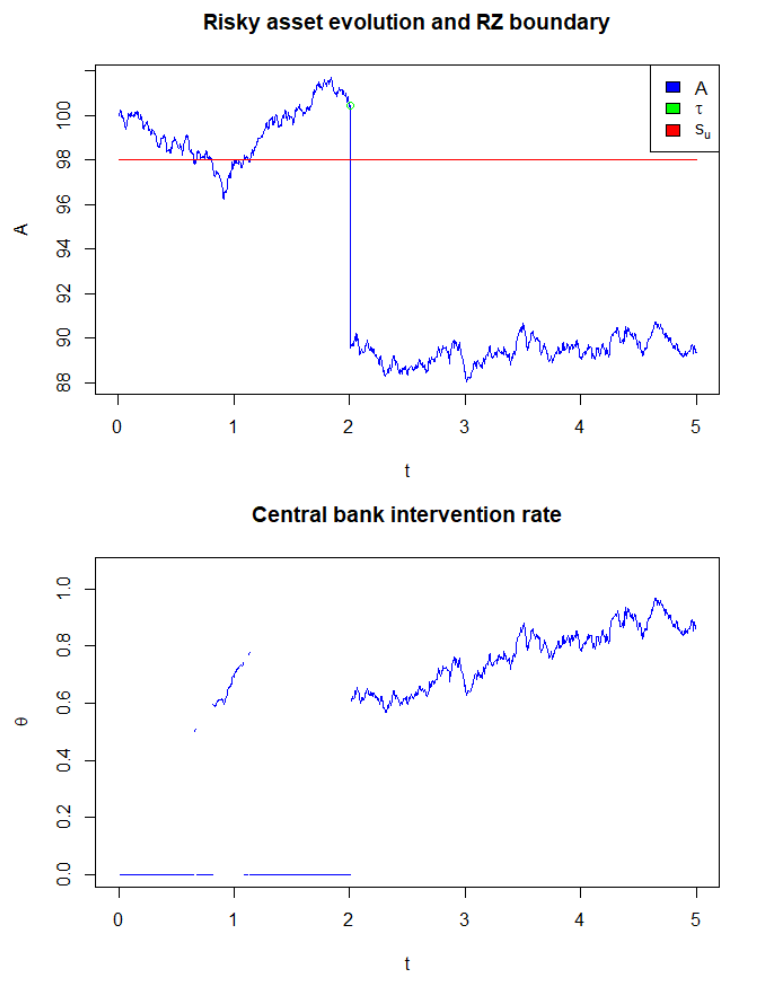
Figure 1. Let us consider a red zone RZ = [ s l = 80, s u = 98 ] , s 0 = 100, µ = 0.1, σ = 2, T = 5. We assume that the compound Poisson process described in Equation (1) has an intensity of λ = 1/3, meaning that one jump is expected every three years. The jump size is assumed to be distributed as a gamma variable with shape parameter 2 and scale parameter 2.5, resulting in a jump size expectation of 5. In the upper figure, the dynamics of the bank’s risky asset is shown, with the green circle τ representing the negative jump and the red line representing the upper bound of the red region. The lower figure shows the dynamics of θ ( · , · ) assuming no dividends and no government intervention over the 5 years considered, and with the parameters C 1 and C 2 equal to 1/100 and 1/2, respectively. For this analysis, it was assumed that h 0 = 0. It can be observed that, after one year, the government is eager to help the bank as the bank’s value is far away from the lower boundary of the red region. However, as time goes by, the government increases the intensity of intervention as the time since the last salvage event has